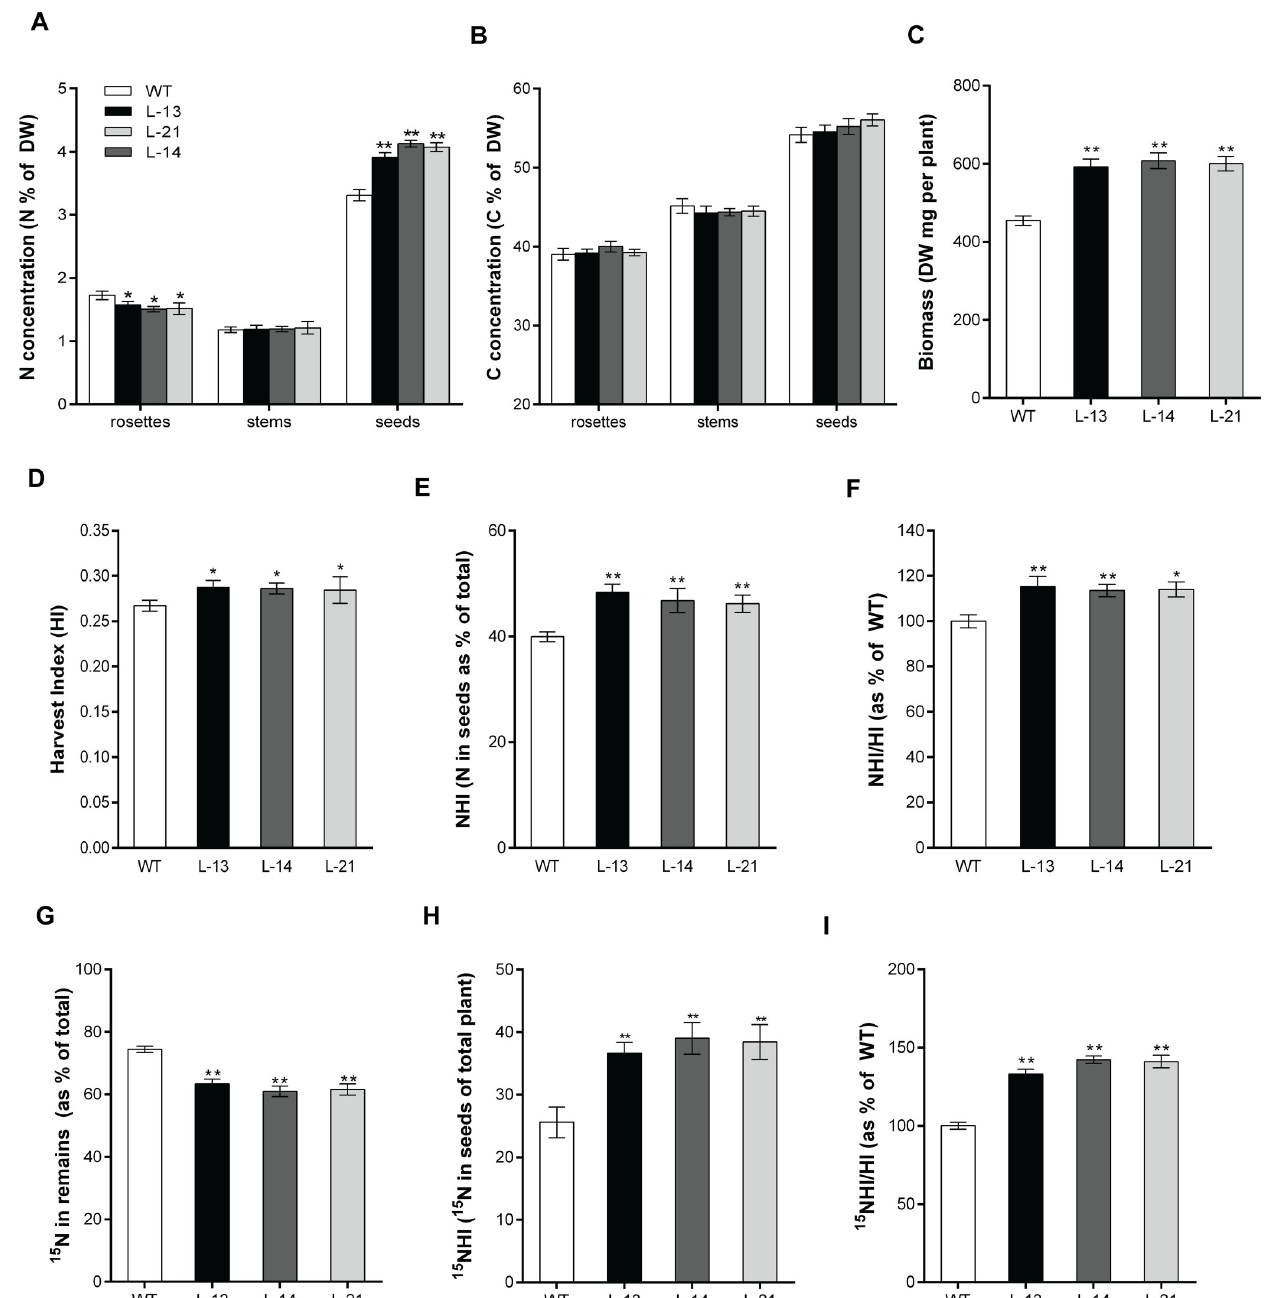
Fig 6. Evaluation of NUE and NRE in transgenic Arabidopsis. (A) N concentration (N%, presented as mg per 100 mg DW) and (B) C concentration (C%, presented as mg per 100 mg DW) of the transgenic lines and WT were measured in rosettes, stems and seeds after harvesting. (C) Biomass accumulation as measured by dry weight of the whole plant. (D) HI was measured as the ratio of the dry weight of total seeds to the dry weight of remains. (E) NHI was measured as the partitioning total N in seeds. (F) NHI/HI ration was calculated as a percentage of WT and used to estimate NUE between the transgenic lines and WT. (G) Partitioning of 15 N in remains of the transgenic lines and WT after harvesting. (H) 15 NHI was measured as the partitioning total 15 N in seeds. (I) 15 NHI/HI ration was calculated as a percentage of WT and used to estimate NRE between the transgenic lines and WT. Values are means ± SD of three biological replicates (n = 12), � P < 0.05, �� P < 0.01 (t-test).